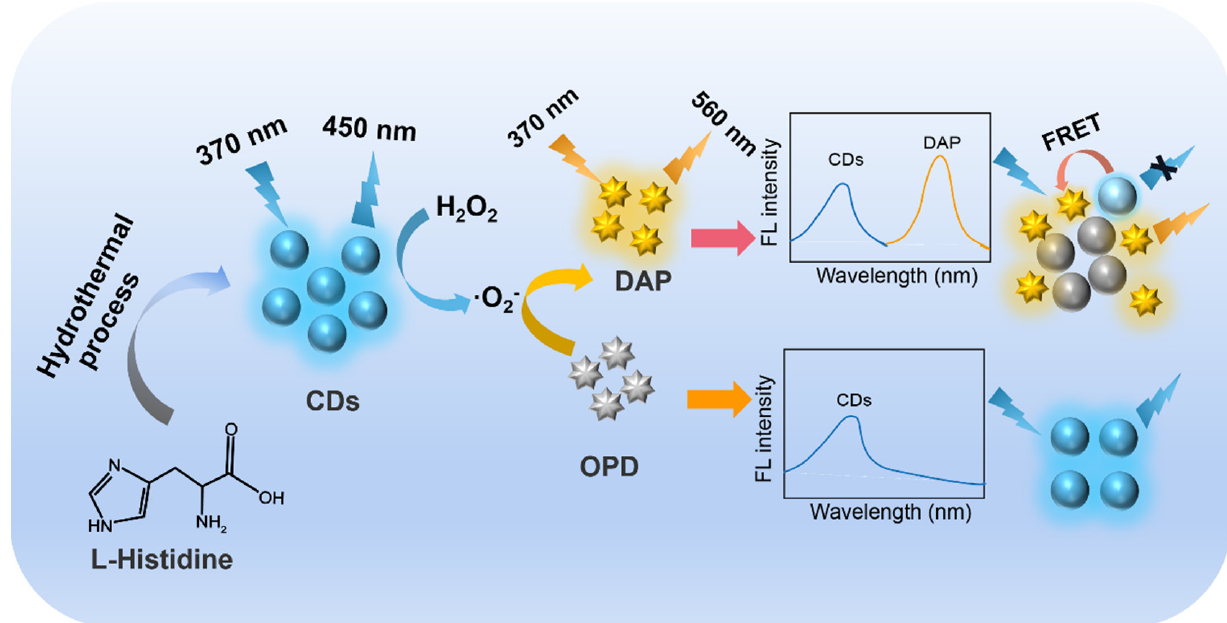
Figure 1. Schematic illustration for the synthesis of CDs and ratiometric fluorescence detection of H 2 O 2 .